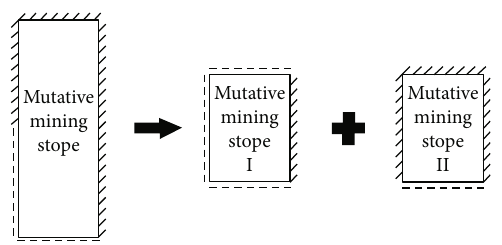
Figure 5: Mechanical model division of mutative mining